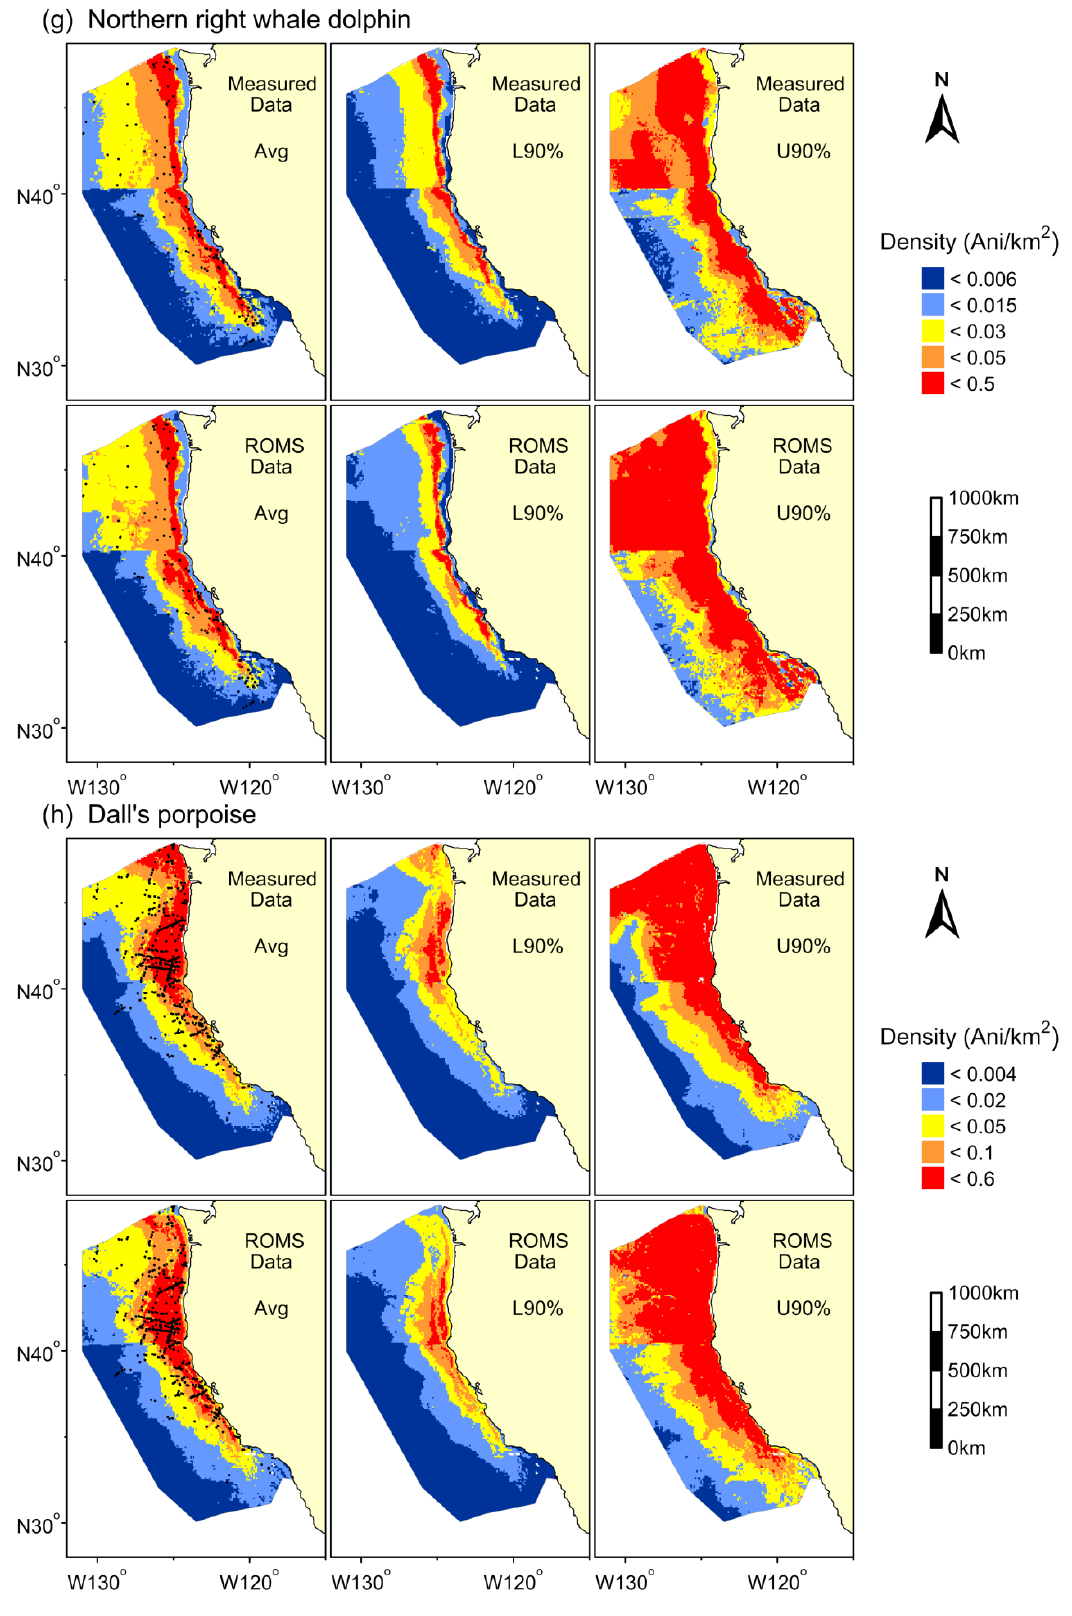
Figure 2. Cont. Figure 2.